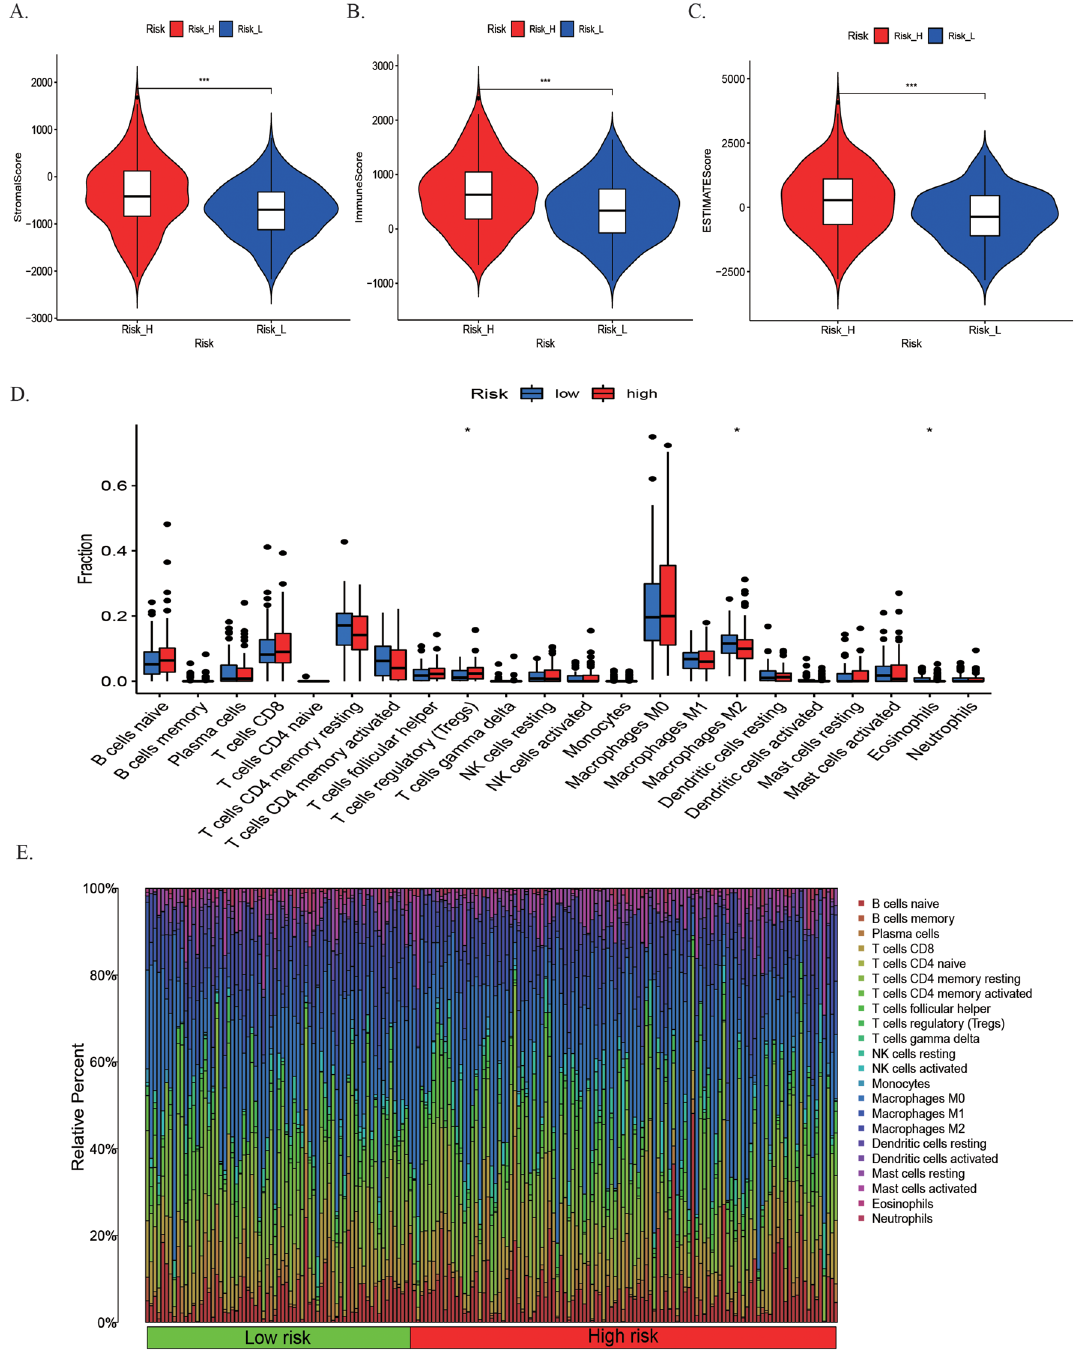
Figure 6. Estimation of the correlation between risk score with TME. (A–C) Comparison the stromal score, immune score and ESTIMATE score between high-risk and low-risk groups. (D) The scores of 22 immune cells in high-risk and low-risk